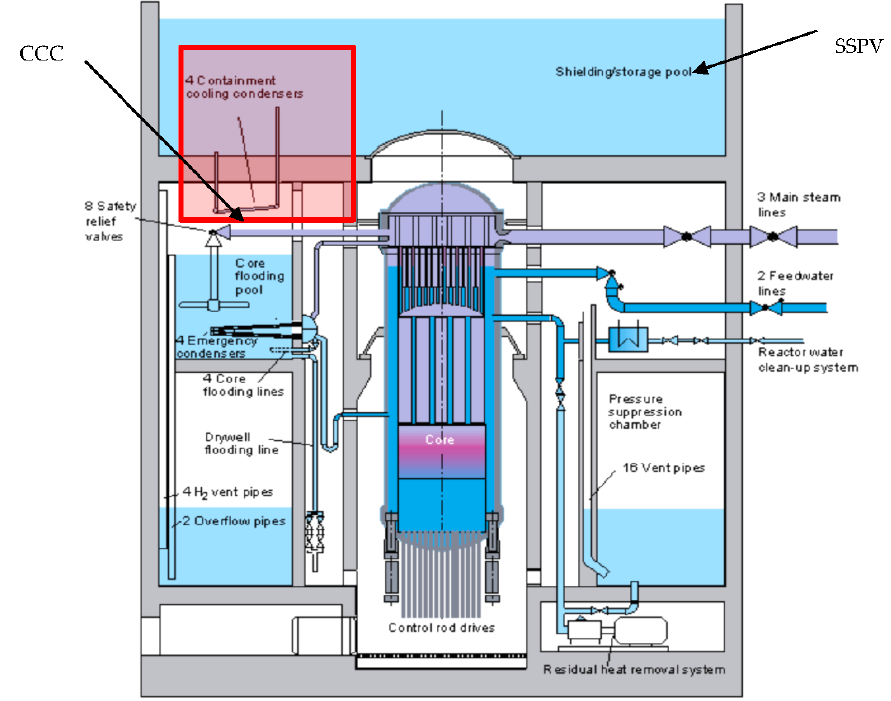
Figure 3. Section picture of KERENA™ containment [30]. CCC: containment cooling condenser; SSPV: shielding/storage pool vessel.